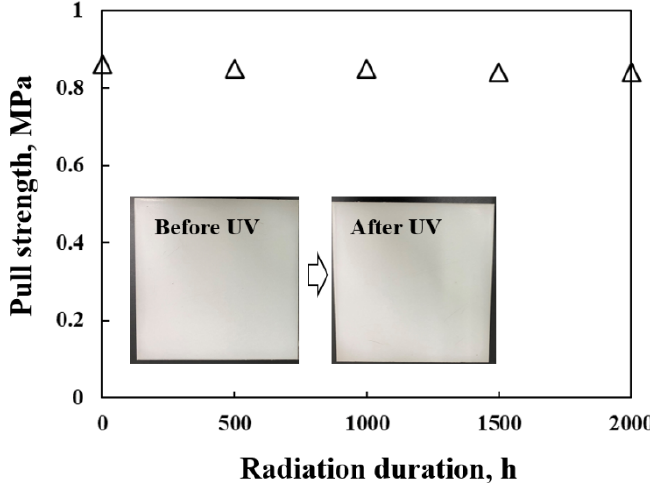
Figure 8. XPS spectrum of the ( a ) bare steel before accelerated corrosion and ( b , c ) the coated steel cured with different carbonation pressure after corrosion.